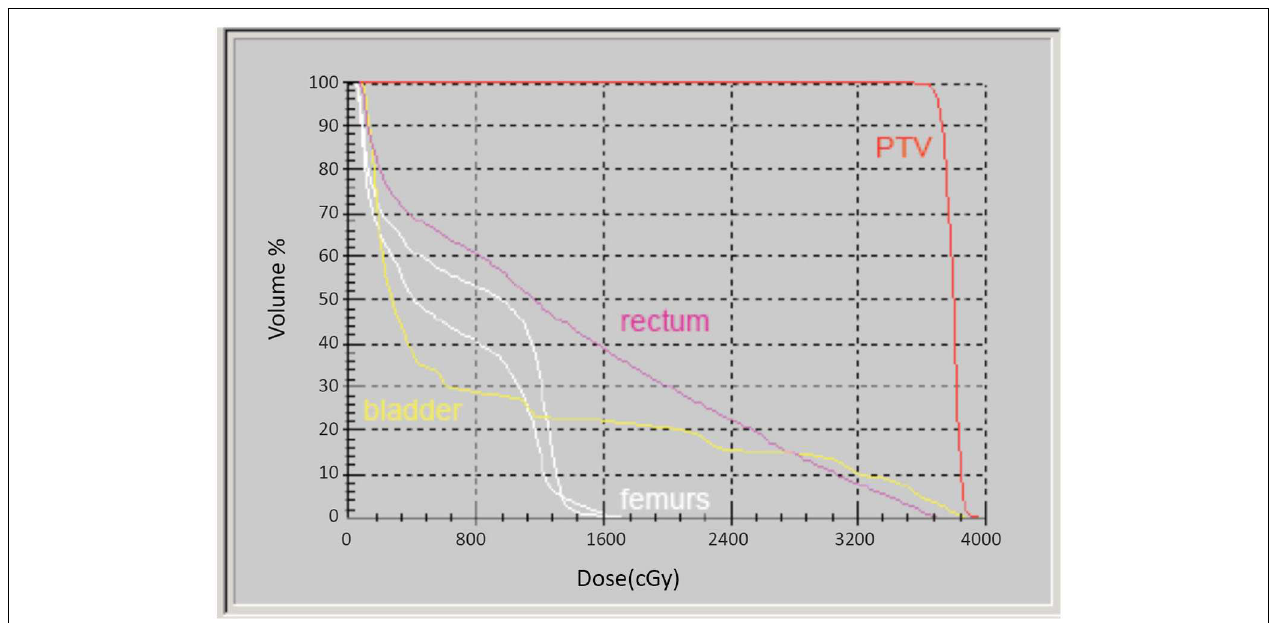
FIGURE 2 | Representative dose-volume histogram of an SABR treatment plan